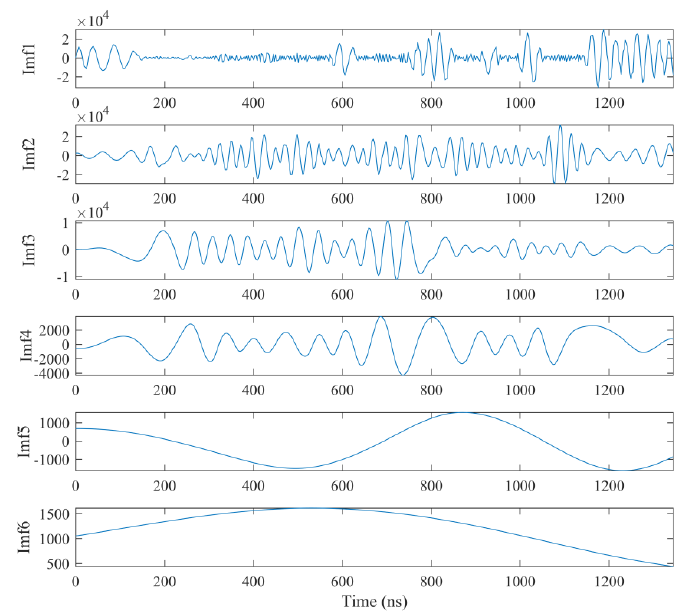
Figure 14. The decomposed IMFs using EMD.